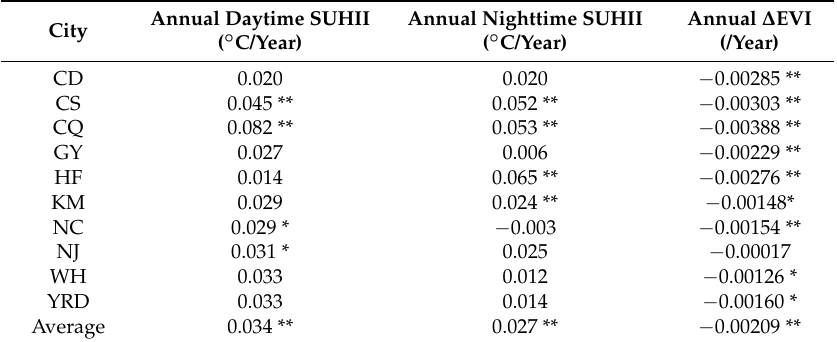
Table 6. Temporal trends of ∆ EVI and SUHII in old urban areas (OUAs) in the YRB, China.